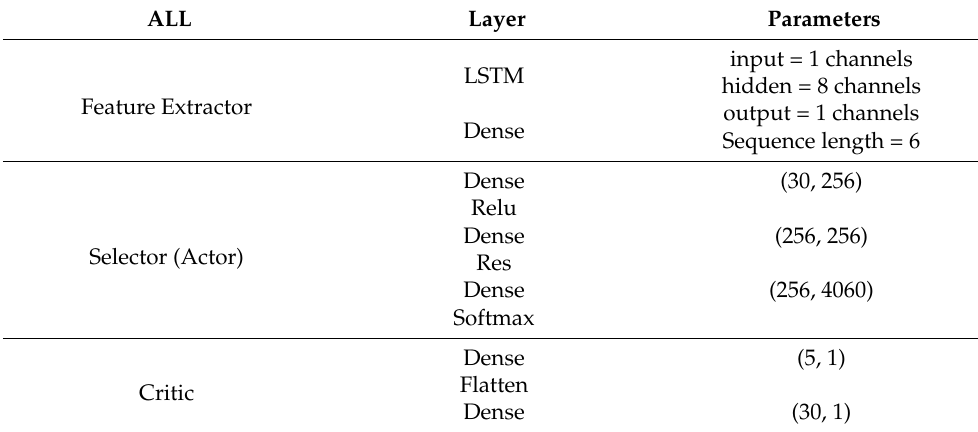
Table 3. Architecture of the proposed